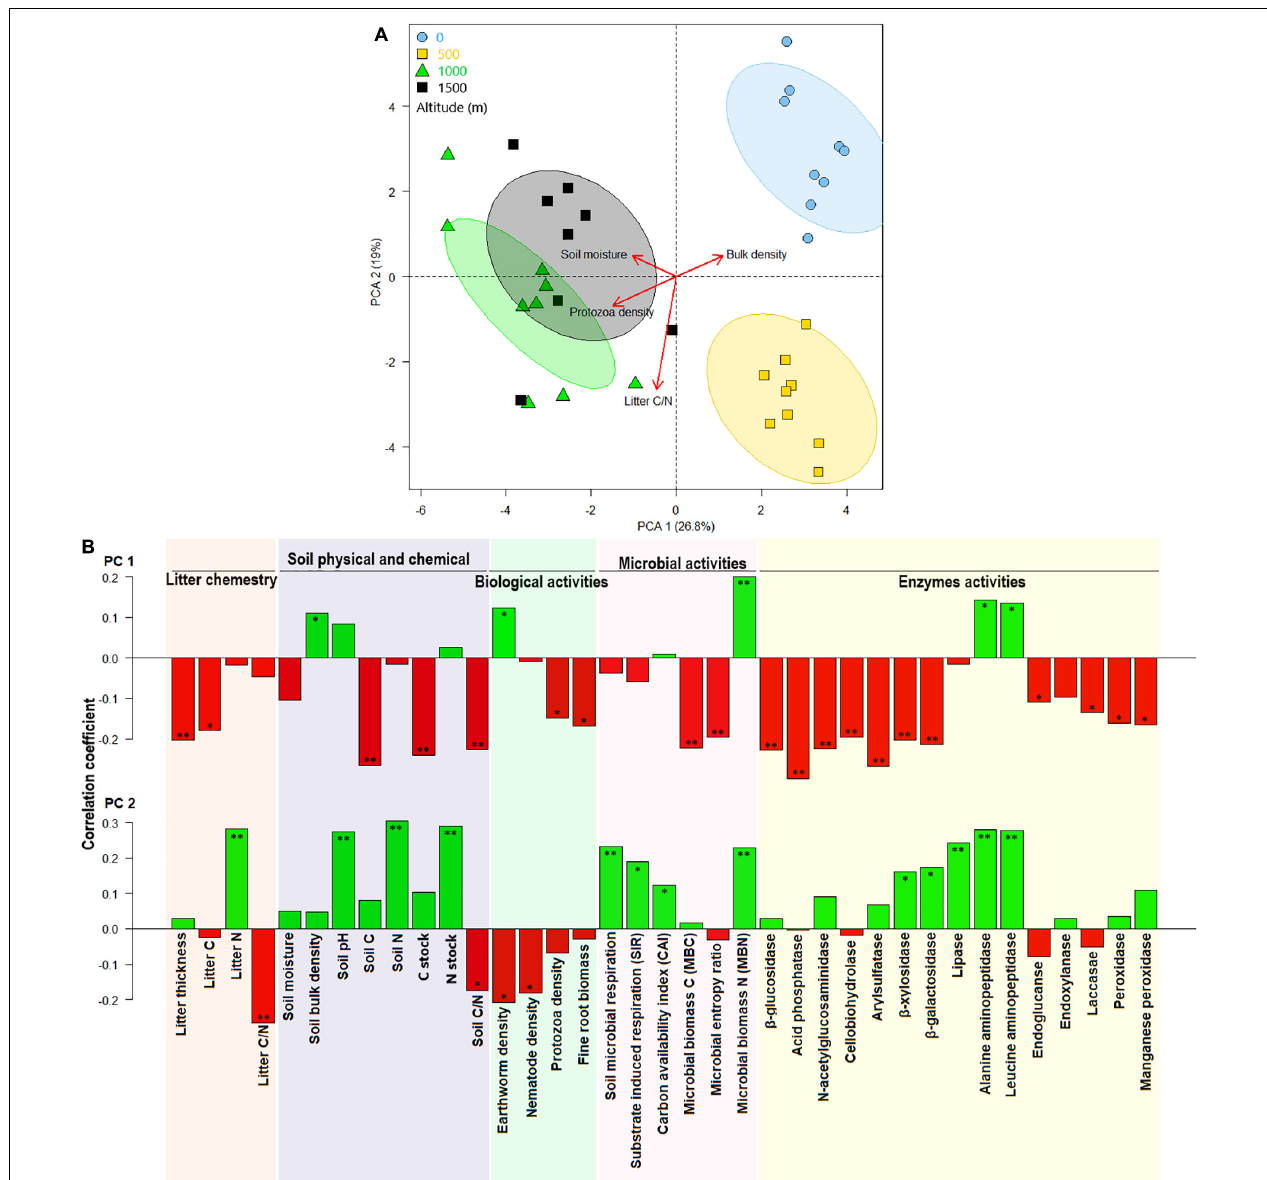
FIGURE 4 | Principal component analysis (PCA) of chemical litter and soil properties and soil biological, biochemical, microbial, and enzyme activities at various altitudes (A) and their correlations with the first two canonical axes (B) . * and ** represents correlation coefficients significant level at p < 0.05 and p < 0.01,